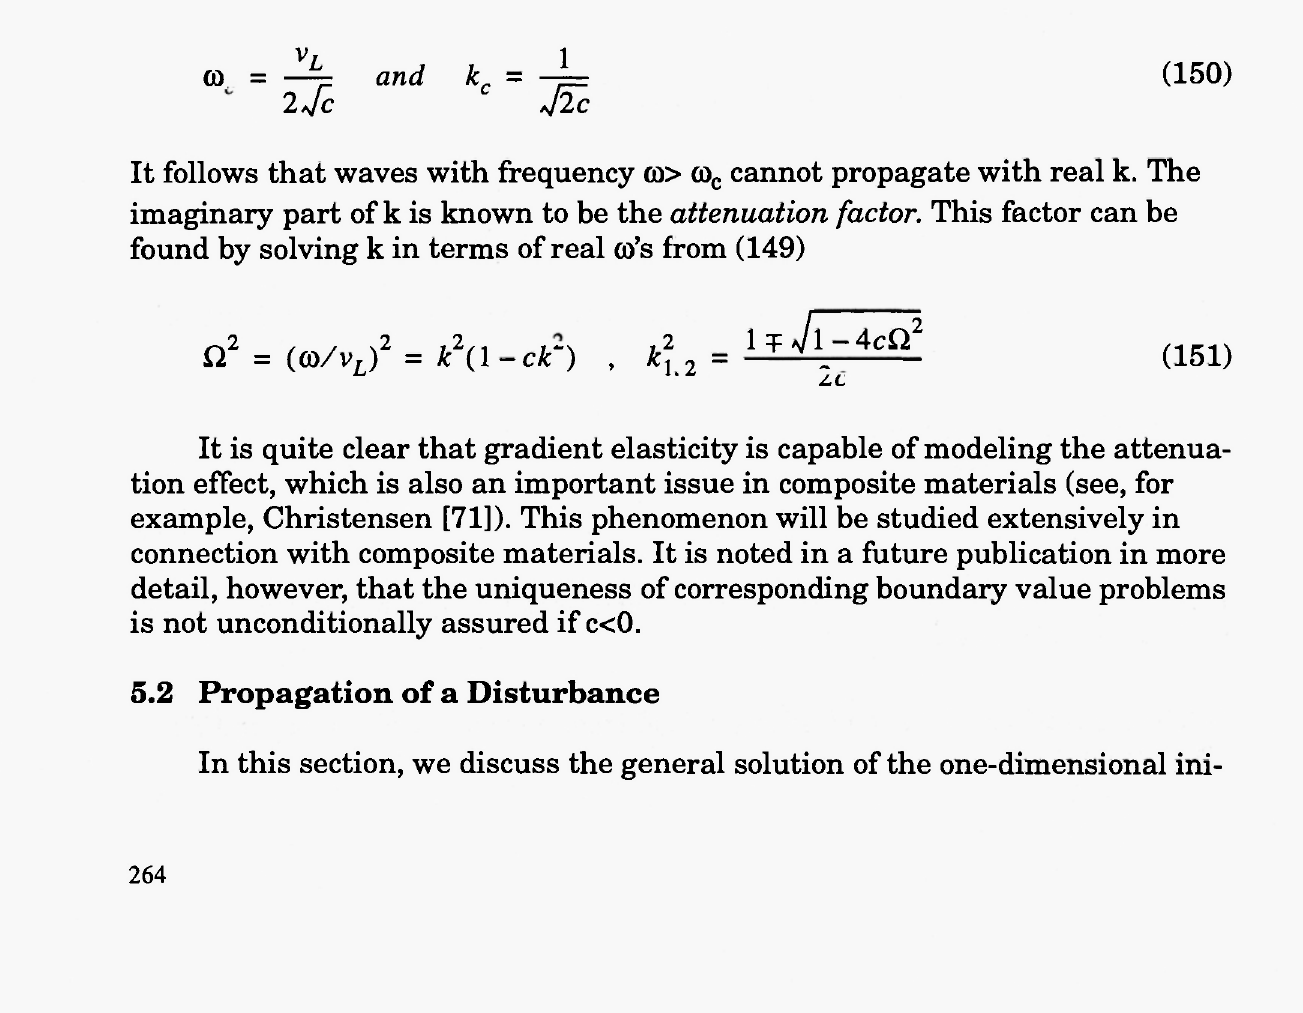
Figure 1: Dispersion relation in one Brillouin